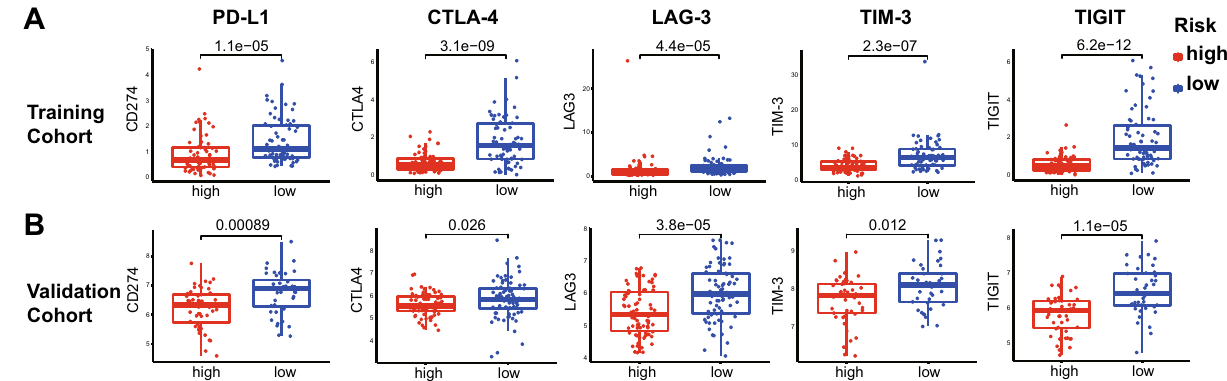
Figure 8. Expression of immune checkpoint genes in different risk groups. ( A ) The expression of immune checkpoint genes, including PD-L1, CTLA-4, LAG-3, TIM-3 and TIGIT, in the training cohort. ( B ) The expression of the same immune checkpoint genes in the validation